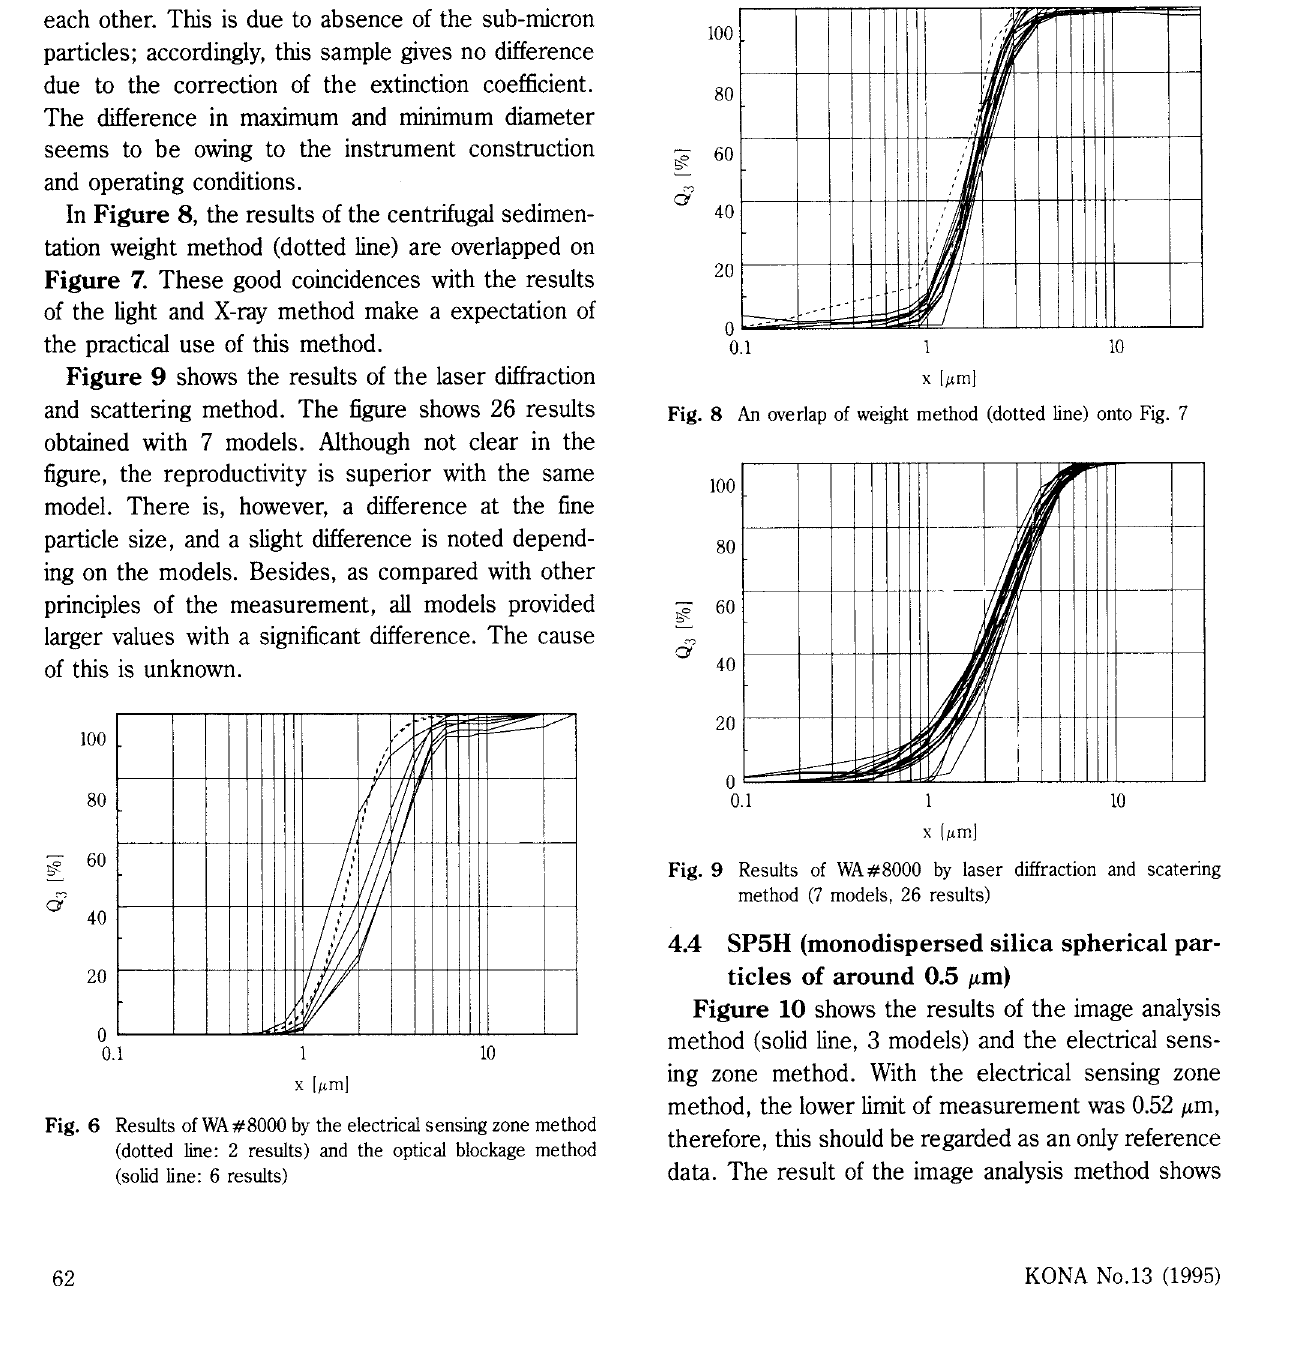
Fig. 7 Results of WA #8000 by sedimentation method (light extinc tion with 1 model, 7 results: dotted line, X-ray absorption with 2 models, 9 results: solid line)